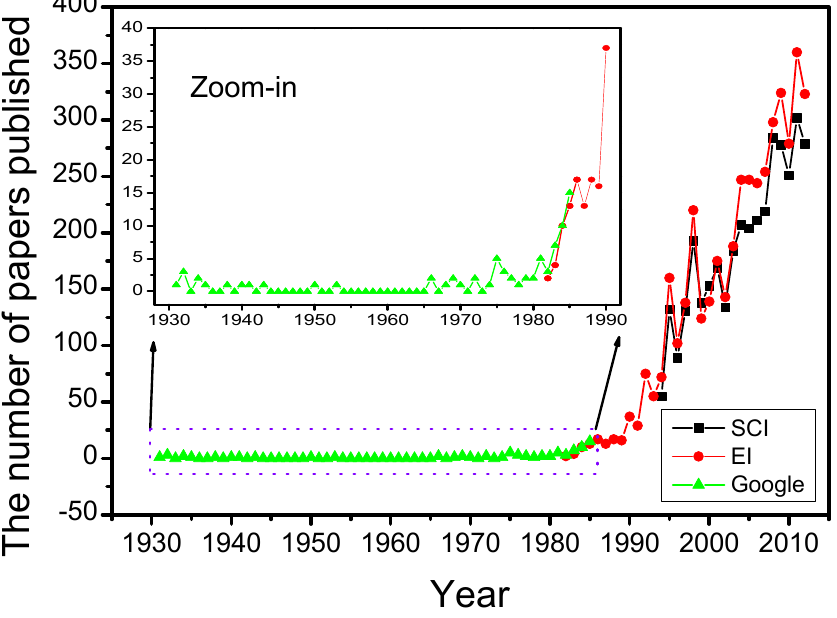
Figure 3. The number of papers published every